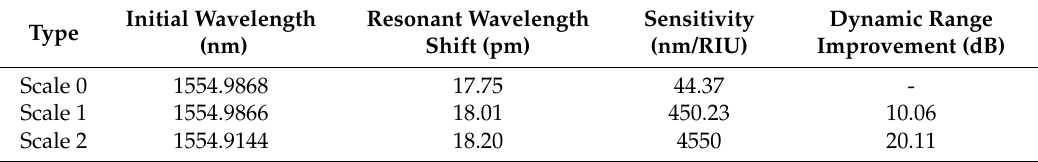
Table 2. Performances of the sensor